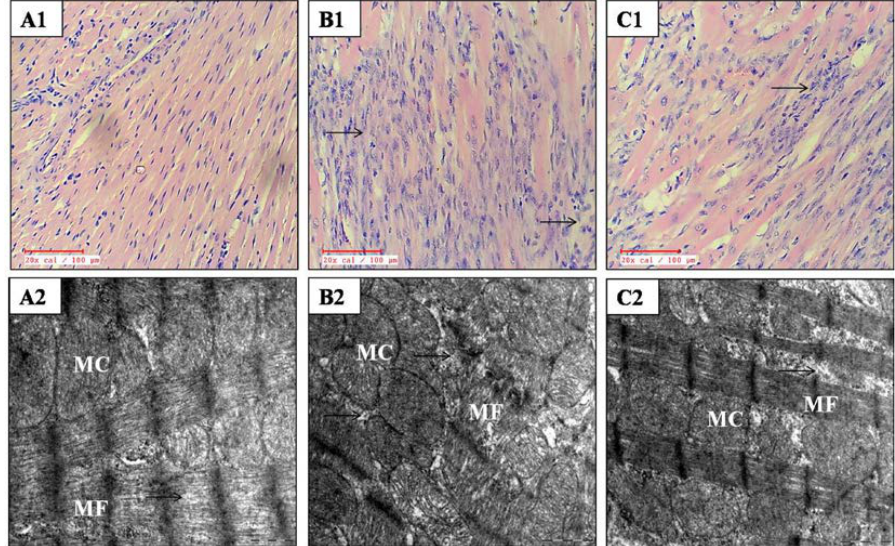
Figure 4. Effect of kaempferol on light microscopy (20×; n = 3 in each group) and electron microscopy (scale bar: 1 μm; n = 3 in each group). ( A1 , A2 ) diabetic control; ( B1 , B2 ) diabetes + ischemia-reperfusion